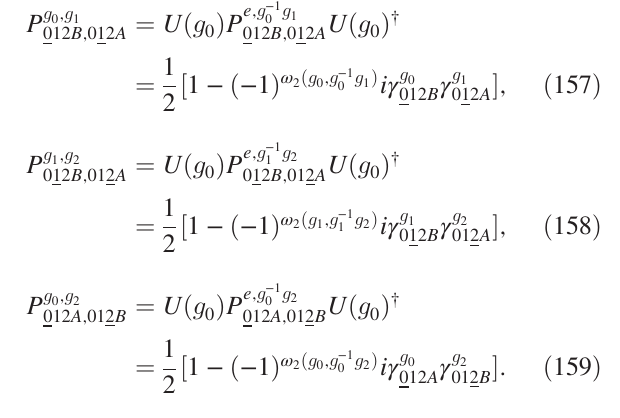
FIG. 4. FSLU transforms a 2D “ FSPT ” state to a fermion product state. There are two FSLU transformations ð a Þ ! trivialize the initial 2D FSPT state. (a) Majorana fermions are in vacuum pairs (green arrows). (b) There is exactly one Kitaev Majorana chain inside the triangle (red links). (c) There is one Kitaev Majorana chain around each vertex (inside the gray arc). And we can shrink it to the vertex and redefine the basis state j g for the i i